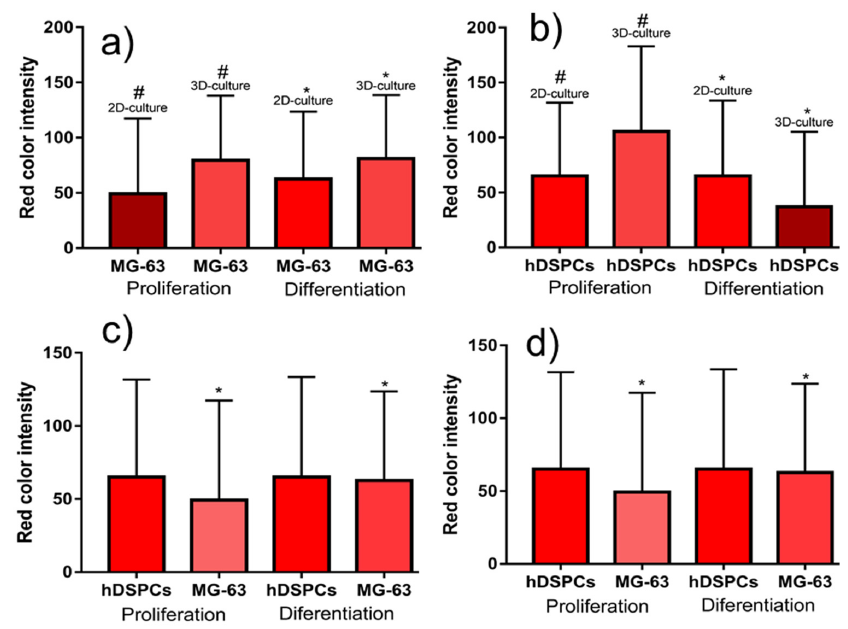
Figure 18. F-actin was quantified by the comparisons made between the same cell line on 2D ( a ) and 3D surfaces ( b ). F-actin intensity color was also used in the comparisons between the same cell line (MG-63) ( c ), (hDPSCs) ( d ). # and * when p < 0.05.